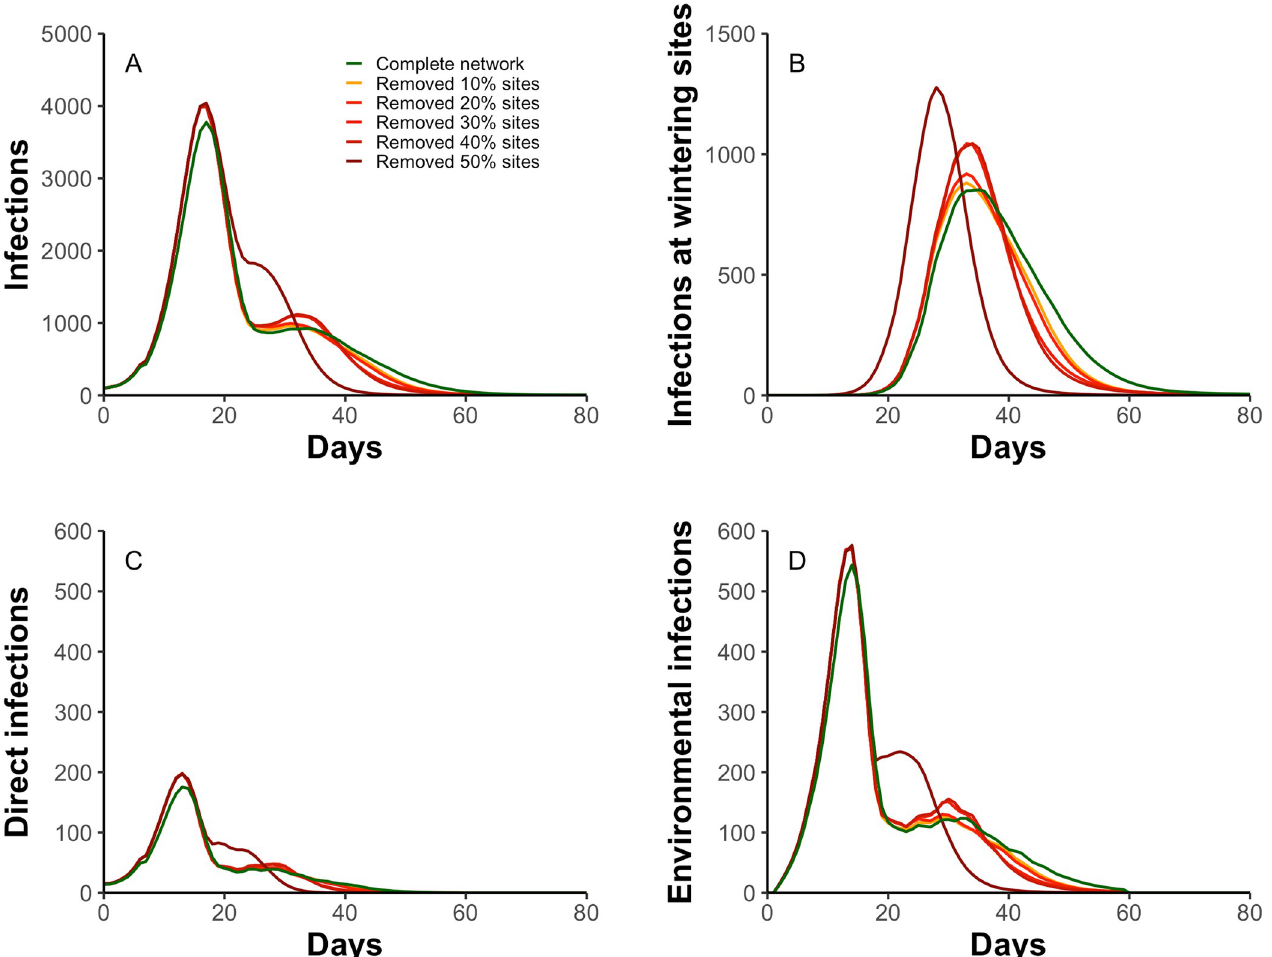
Fig 4. The dynamics of infection prevalence in the migratory population. A) number of infections; B) number of infections at the wintering sites; C) number of infections caused by direct transmission; D) number of infections caused by indirect environmental transmission. Line colors represent the infection dynamics under different network